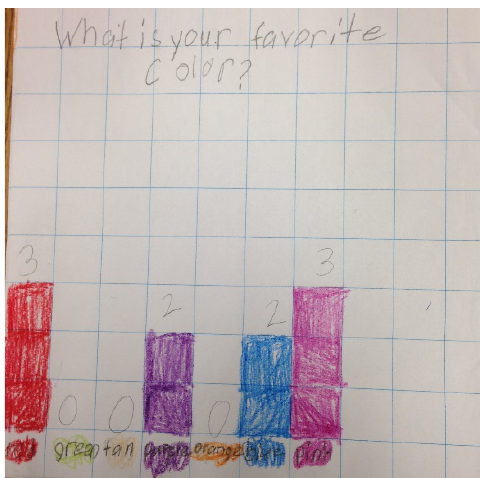
Figure 2. Student graph of survey data to determine the most popular playdough color (Kindergarten